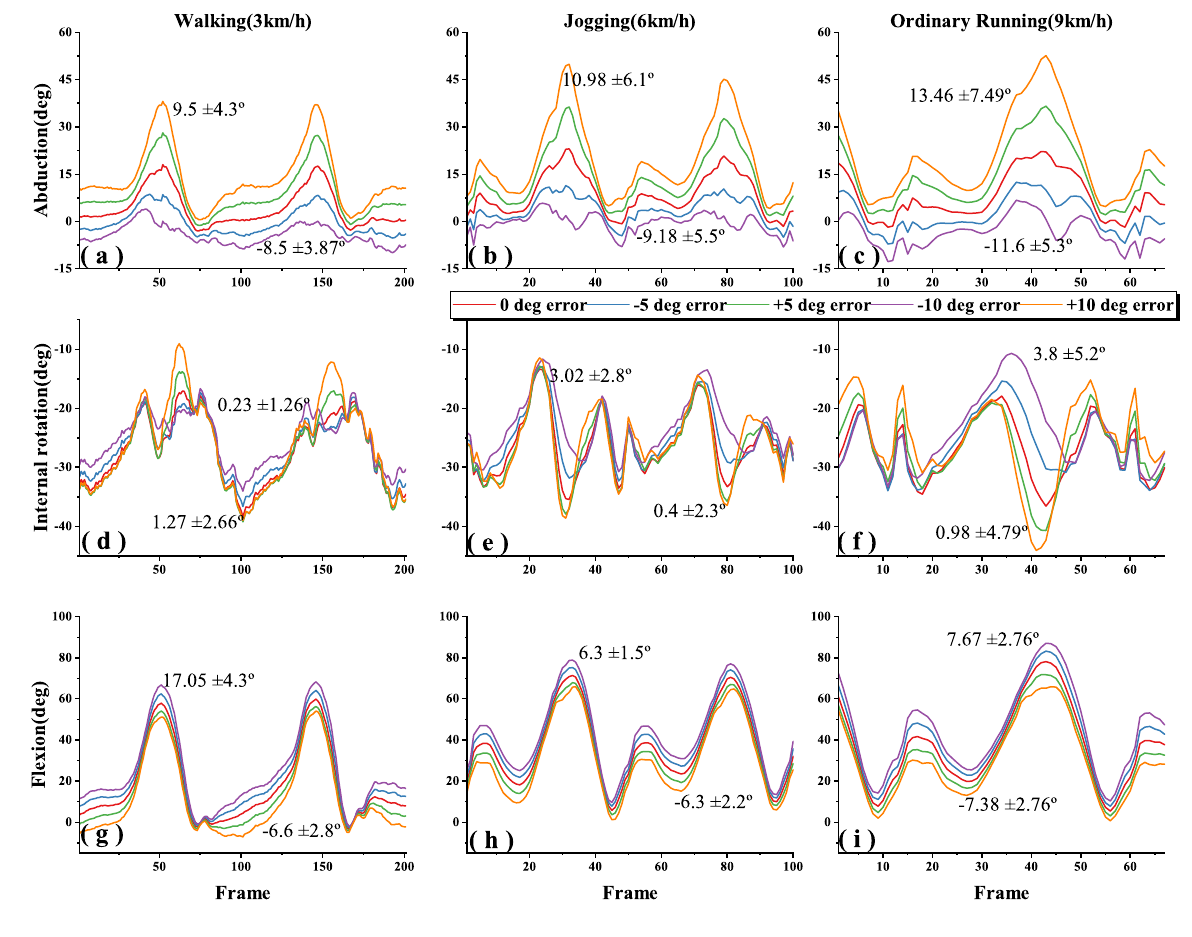
Figure 7. Effects of both IMU to thigh and shank misalignment error on 3-DOF knee angle estimation during different motions; ( a – c ), ( d – f ), ( g – i ) indicate the abduction, internal rotation and flexion angles of the knee during walking (3 km/h), jogging (6 km/h) and ordinary running (9 km/h), when added IMU to thigh and shank misalignment error from − 10 ◦ to +10 ◦ in steps of 5 ◦ .